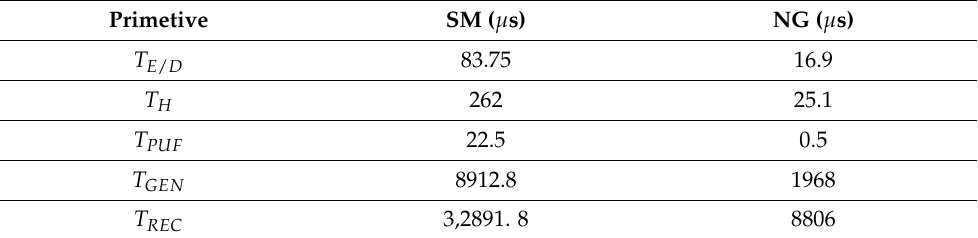
Table 2. Cost comparison of different primitives in micro-second, when a Quad-core Cortex-A72